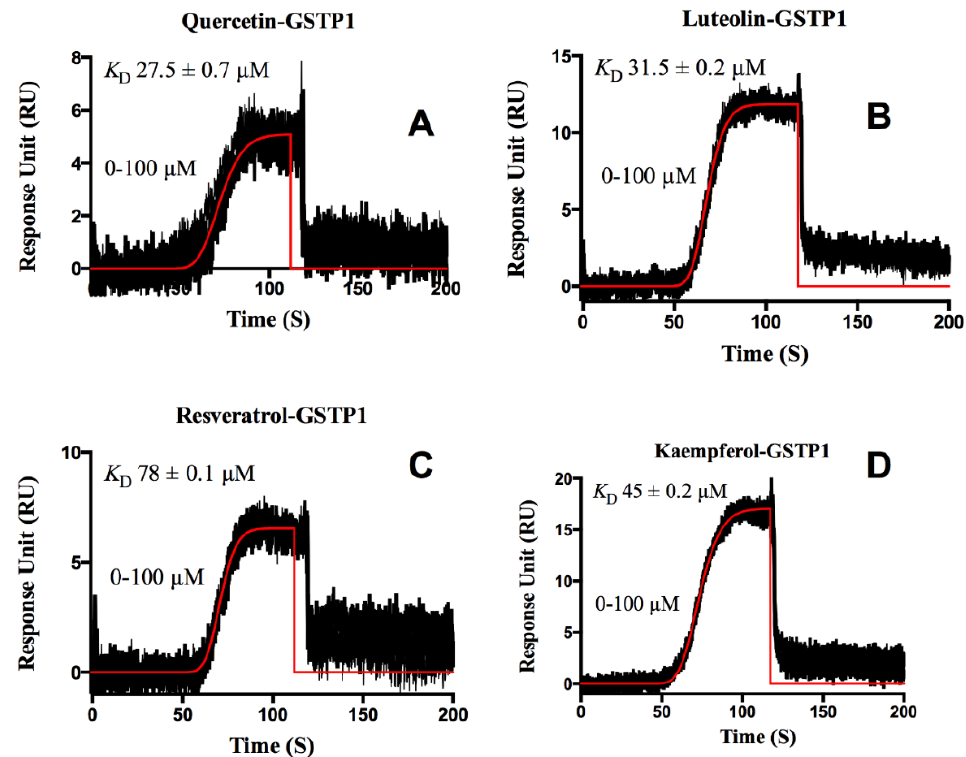
Figure 6. Sensorgrams of flavonoids interacting with GSTP1 (Panels A – D ). The orange lines show a global fit to the response data used to extract binding constants using a 1:1 equilibrium analysis model. The concentration range tested is indicated in each panel. The K D obtained from equilibrium analysis is also indicated in each panel.